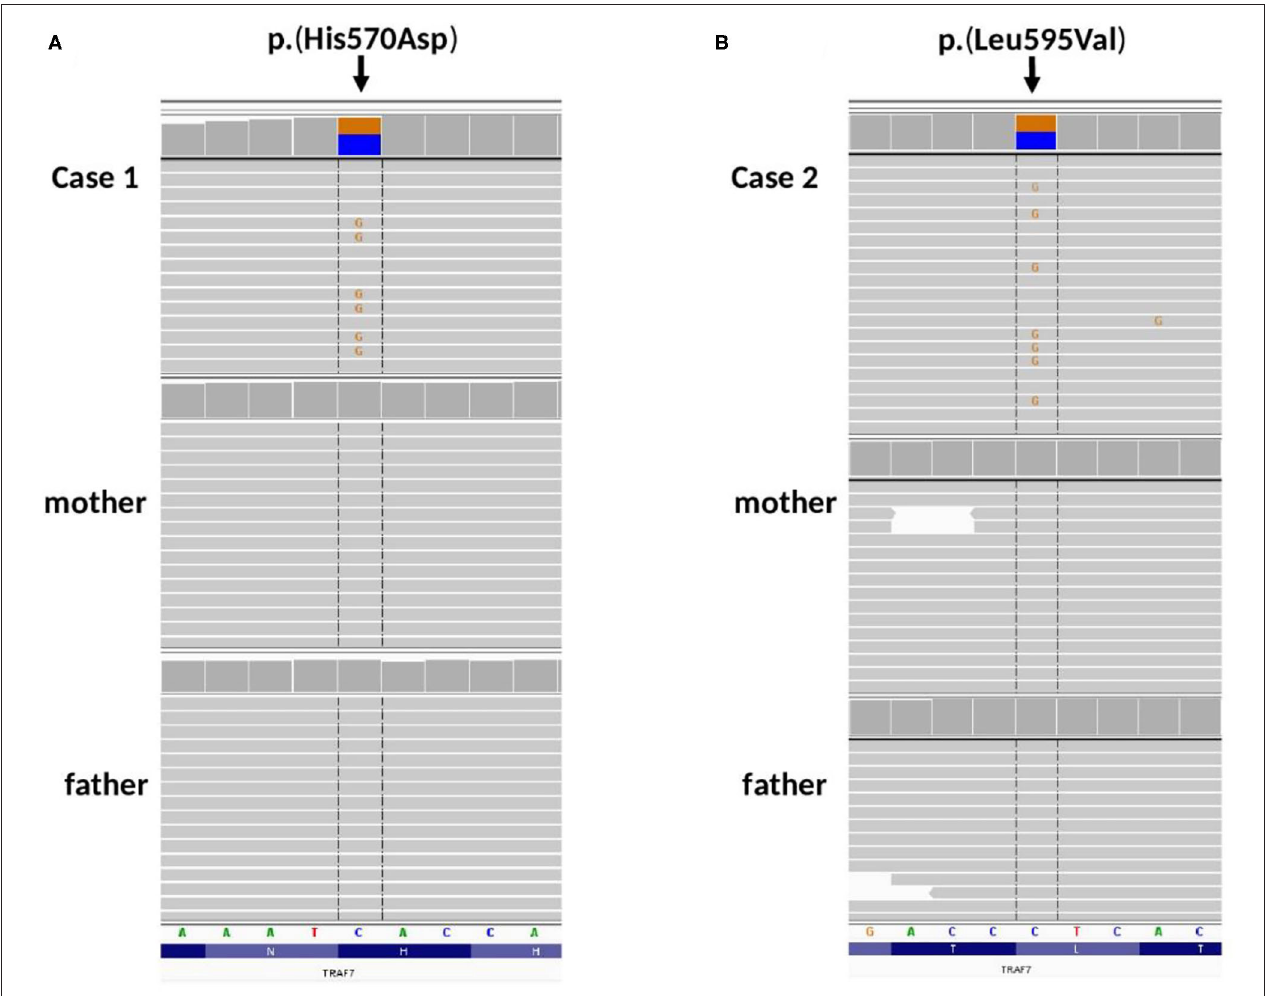
FIGURE 3 | Amplicon deep sequencing validation of TRAF7 gene variants identified by WES in (A) Case 1, de novo p.(His570Asp), (B) Case 2, de novo p.(Leu595Val). Integrative Genomic Viewer screenshots are